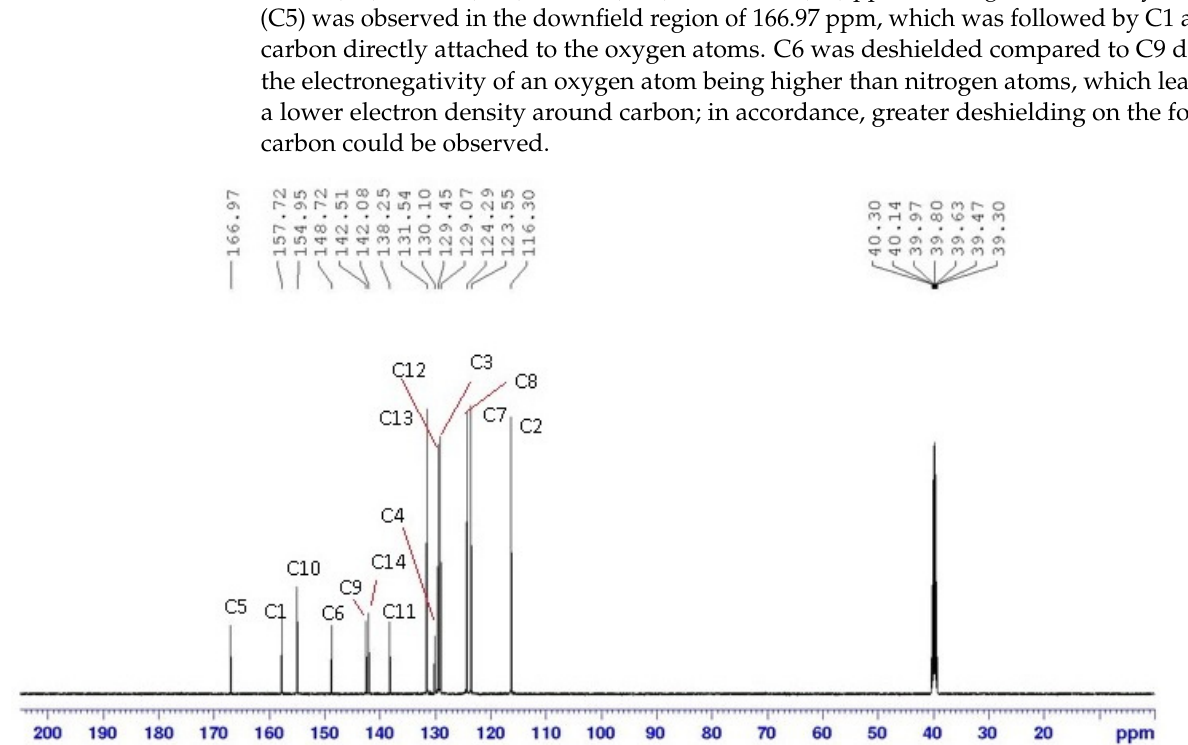
Figure 4. 13 C NMR (125 MHz, DMSO-d 6 ) of compound 4a.